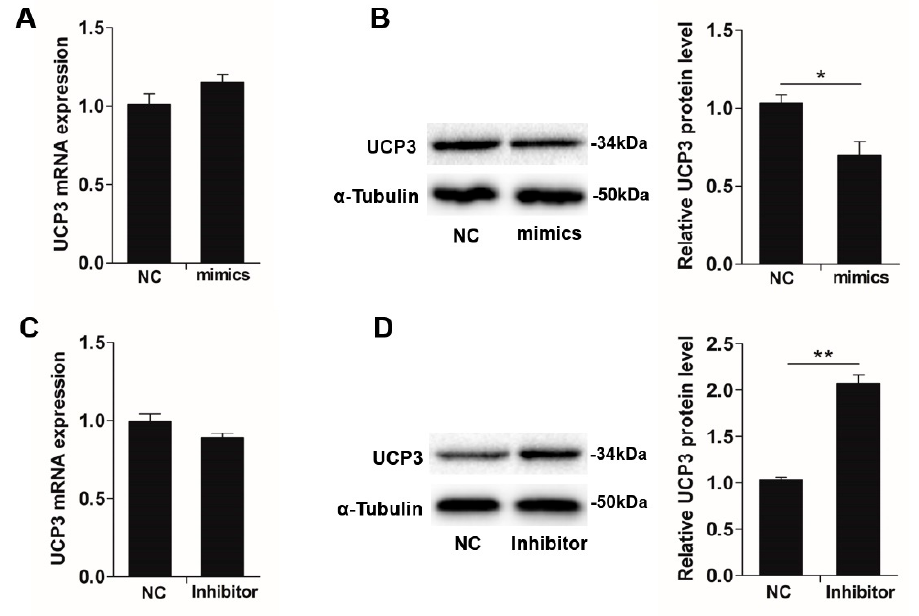
Figure 5. miR-152 downregulates UCP3 expression in the protein level. UCP3 expression in porcine myotubes transfected with miR-152 mimics were determined in mRNA ( A ) and protein ( B ) levels by qPCR and immunoblotting, respectively. UCP3 expression in porcine myotubes transfected with the miR-152 inhibitor were determined in mRNA ( C ) and protein ( D ) levels by RT-qPCR and immunoblotting, respectively. α -Tubulin served as the loading control. Results are exhibited as the mean ± S.E.M. ( n = 4, four independent experiments). * p < 0.05 as contrasted with the control.